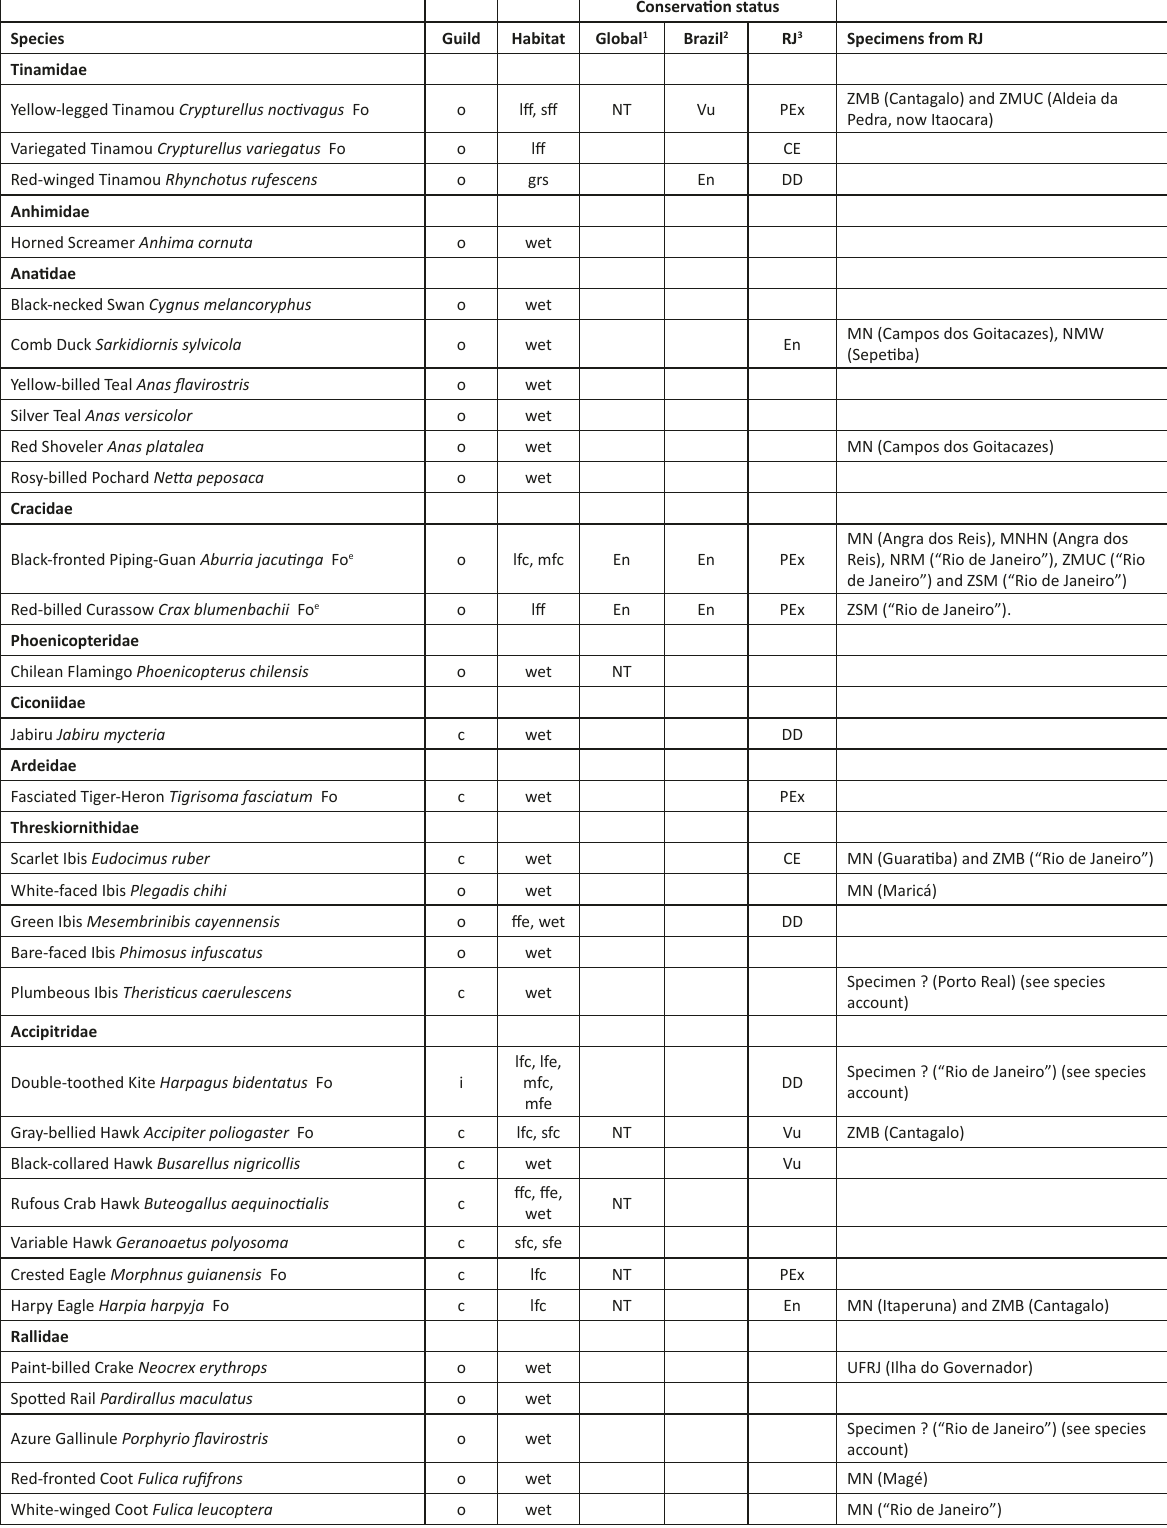
Table 1. The locally rarest bird species in the state of Rio de Janeiro, their trophic guilds, habitat preference, conservation status according to the literature and specimens from Rio de